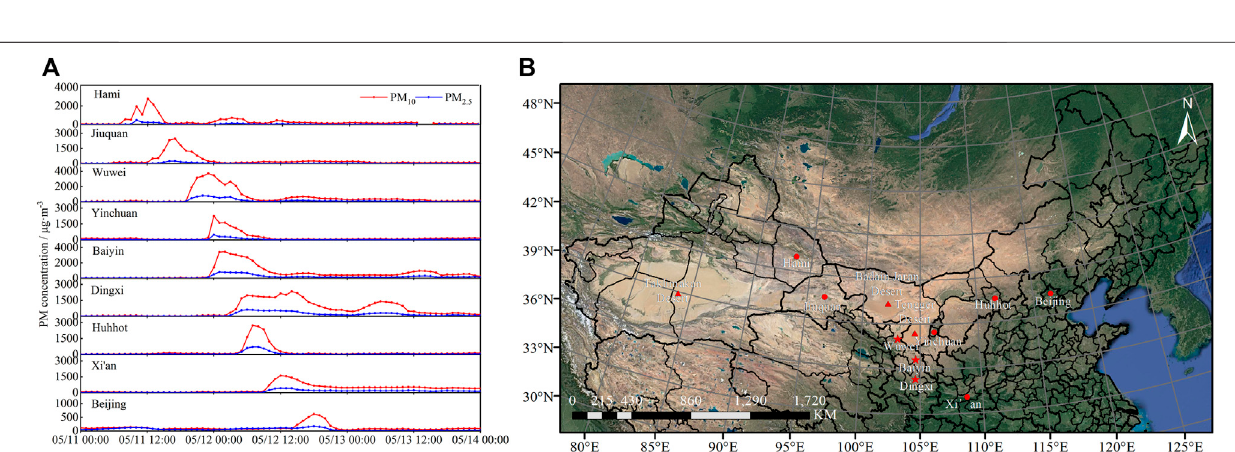
Frontiers in Environmental Science |